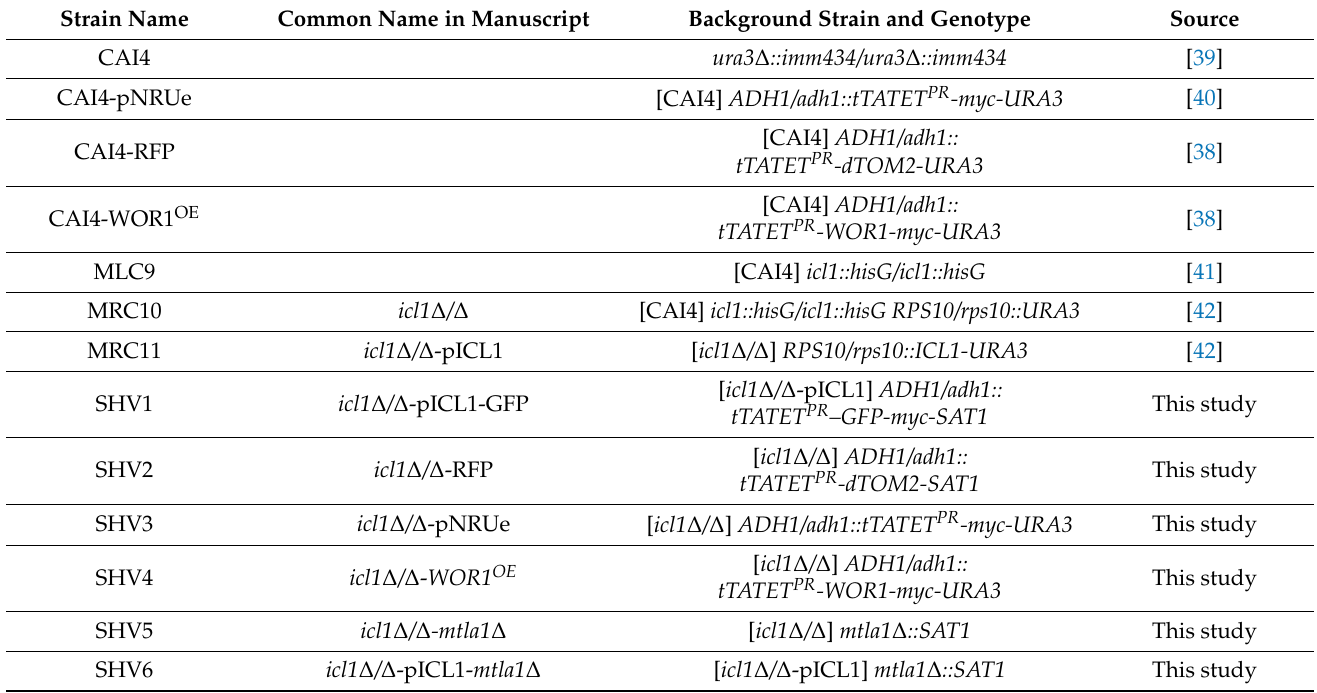
Table 1. Strains of C. albicans used in this